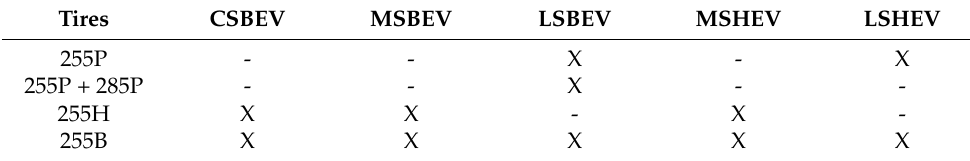
Table A2. Experiment design without weight